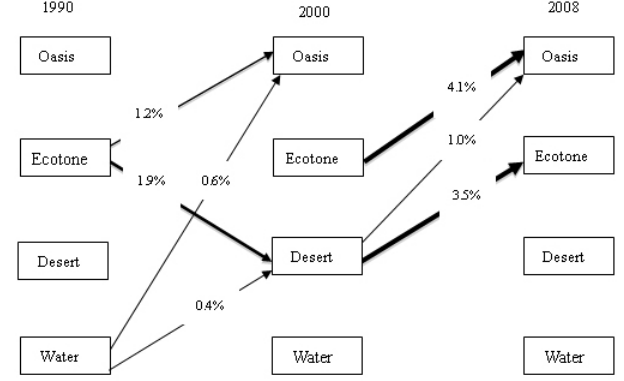
Figure 5. Major change trajectories and their contributions to net change in percentage of the study area (thick lines correspond to net change > 3.5%, intermediate lines correspond to net changes between 1.8 and 3.5% and thin lines correspond to net change < 1.8%; only net contributions to change > 5000ha, or 0.4% of the study area, are represented).